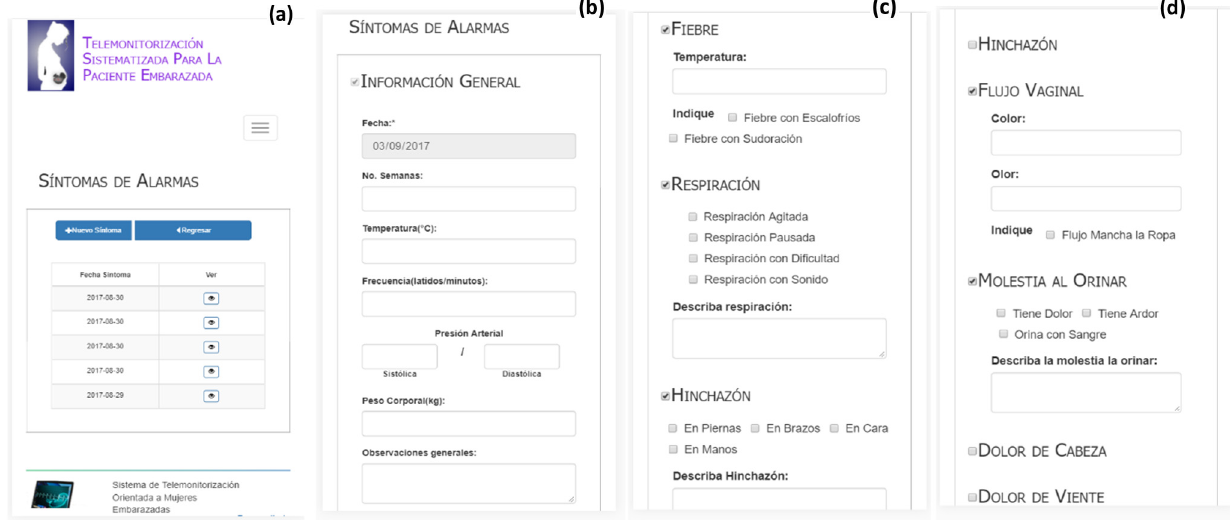
Figure 6. Alarms symptoms (from left to right): ( a ) list, ( b ) general information, ( c ) fever, breathing, and swelling data, and ( d ) vaginal fluid data and discomfort during urination.